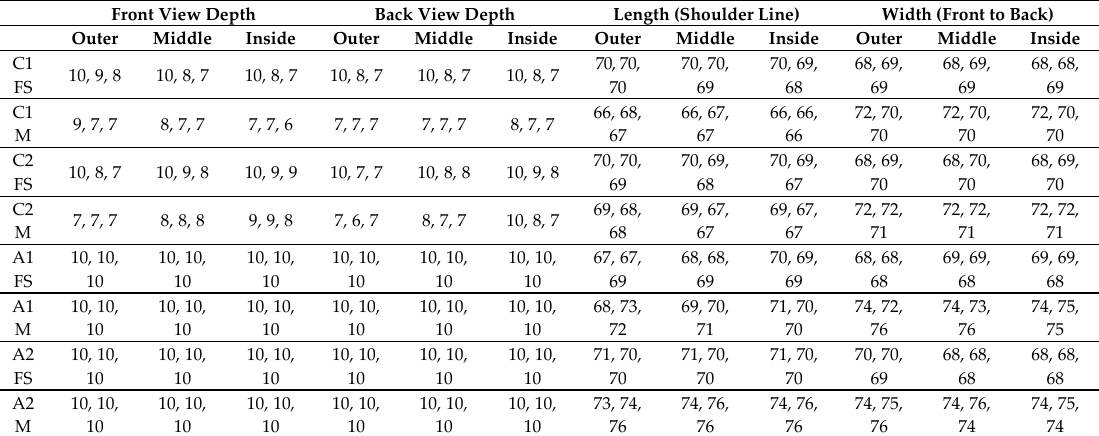
Table 2. Measurements taken to the nearest millimetre of the depth (front and back), length and width of auxetic (A1 and A2) and conventional foam (C1 and C2) attached to a sports top, both on a flat surface (F) when subject to no tension and on a mannequin (M) and subject to tension. Front View Depth Back View Depth Length (Shoulder Line) Width (Front to Back) Outer Middle Inside Outer Middle Inside Outer Middle Inside Outer Middle Inside